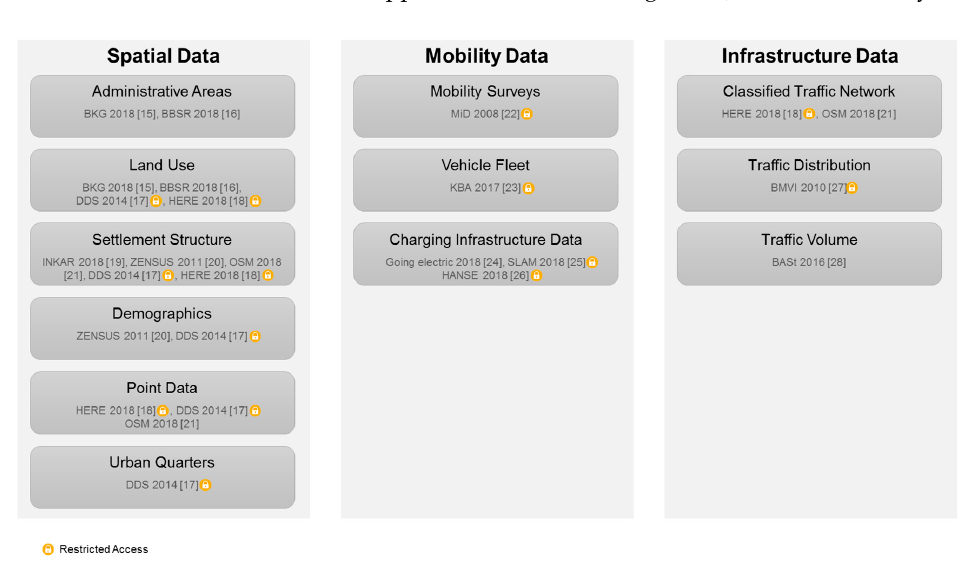
Figure 1. Actual overview of the used input data in the model approach “STandortfindungsmodell für ELektrische LAdeinfrastruktur” (STELLA) (own depiction, state of 31 January 2018) [15–28]. One basis for the model approach STELLA is the calculation of the generated traffic volume for each small-scale urban quarter [17], which is formed depending on the 8-digit postcode level (PLZ8). The PLZ8 divides Germany into approximately 82,000 urban districts and represents a differentiated subdivision of the 5-digit postcodes into homogenous territorial units containing, on average, about 500 households each [17]. To determine the volume of the generated traffic in each urban quarter, the FGSV method from 2010 is used, which is, however, modified in the modal split calculation for the model approach STELLA. Within the FGSV method, the traffic volume is determined in a first step depending on the type of urban quarter investigated (residential, mixed and commercial zone) [29].